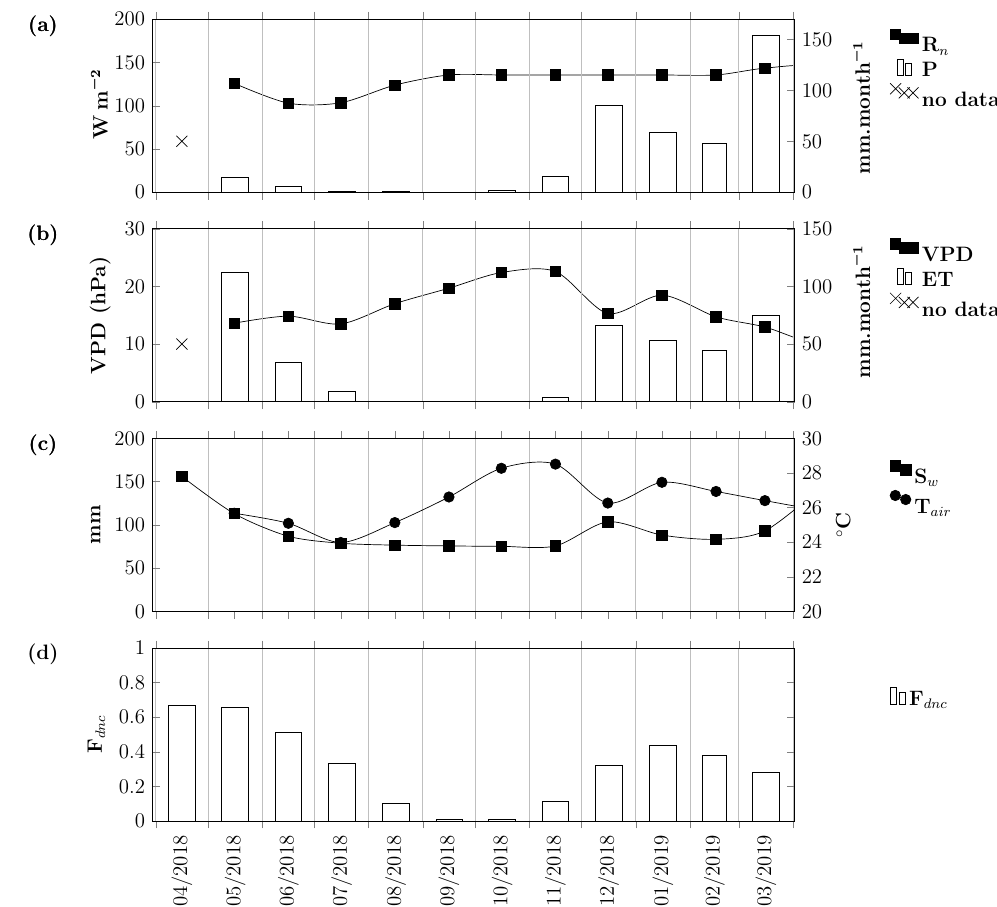
Figure 5. Climate variables, soil water availability, and community-level sap flow: ( a ) Net Radiation (R n , W m − 2 ) and rainfall (P, mm month − 1 ); ( b ) vapour pressure deficit (VPD, hPa) and EC evapo- transpiration (ET, mm month − 1 ); ( c ) soil water storage (S w , mm) and monthly mean air temperature (T air ; ◦ C); ( d ) Normalized sap flow for the plot community (F dnc ,